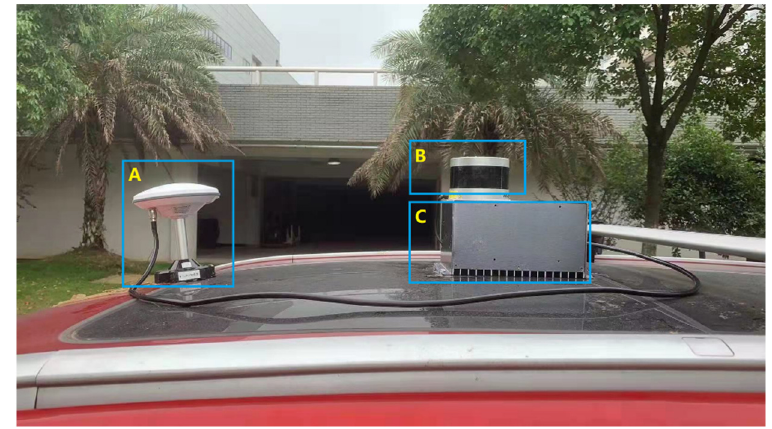
Figure 3. The MMS built in this paper integrates LiDAR, GNSS, IMU, and the Raspberry Pi operating system, which can be controlled by a mobile phone. ( A ) is a GNSS antenna; ( B ) is a VLP-16 LiDAR; ( C ) is internally integrated with the Raspberry Pi operating system, IMU, and GNSS board. Table 1. Characteristics of the gyroscopes and accelerometers of the Honeywell HG4930 imu. In Run Bias Varia- Device Sensor tion at Constant Random Walk Max Input Temperature Honeywell Gyroscope 1°/h 0.09°/ √ hr ±200°/sec HG4930 Accelerometer 0.3 mg 30 ug/ √ Hz ±20 g